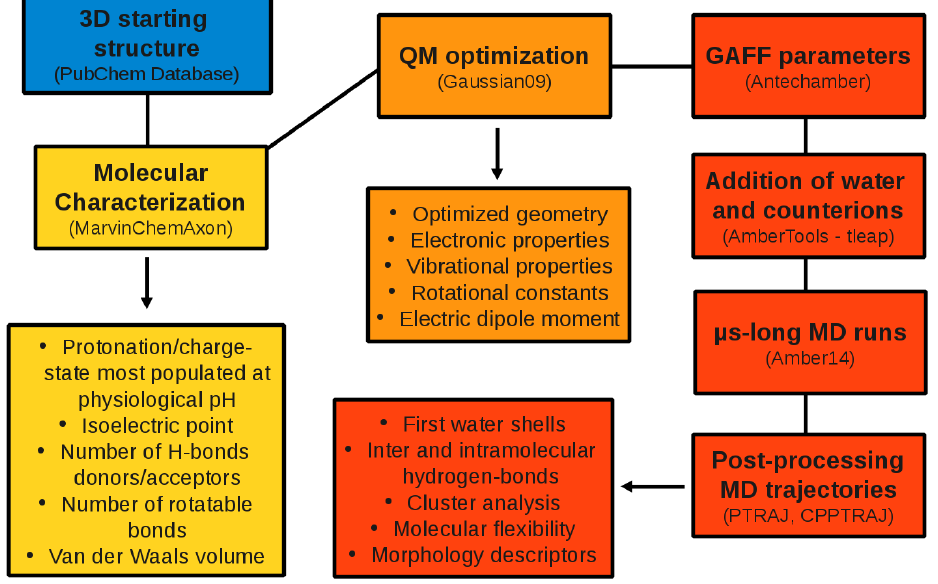
Figure 1. Computational protocol adopted (See Section 2 for a